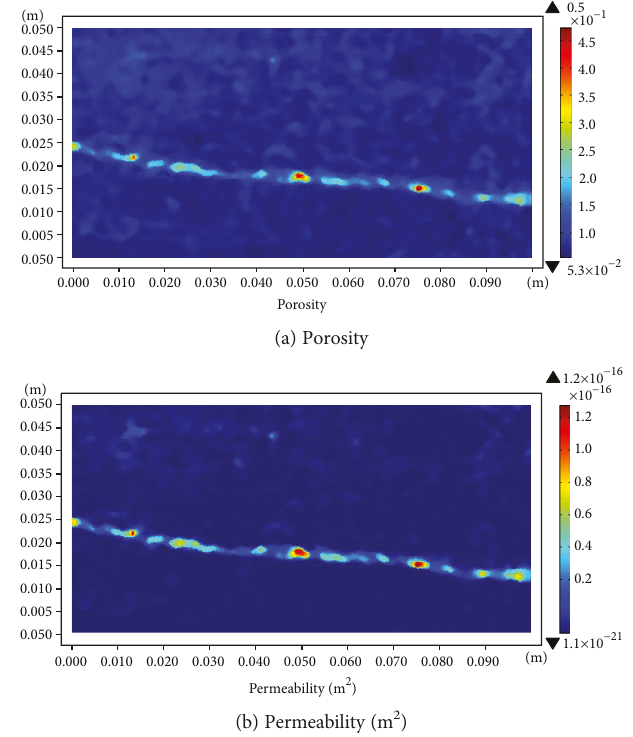
Figure 10: Initial porosity (a) and permeability (b) of the system.